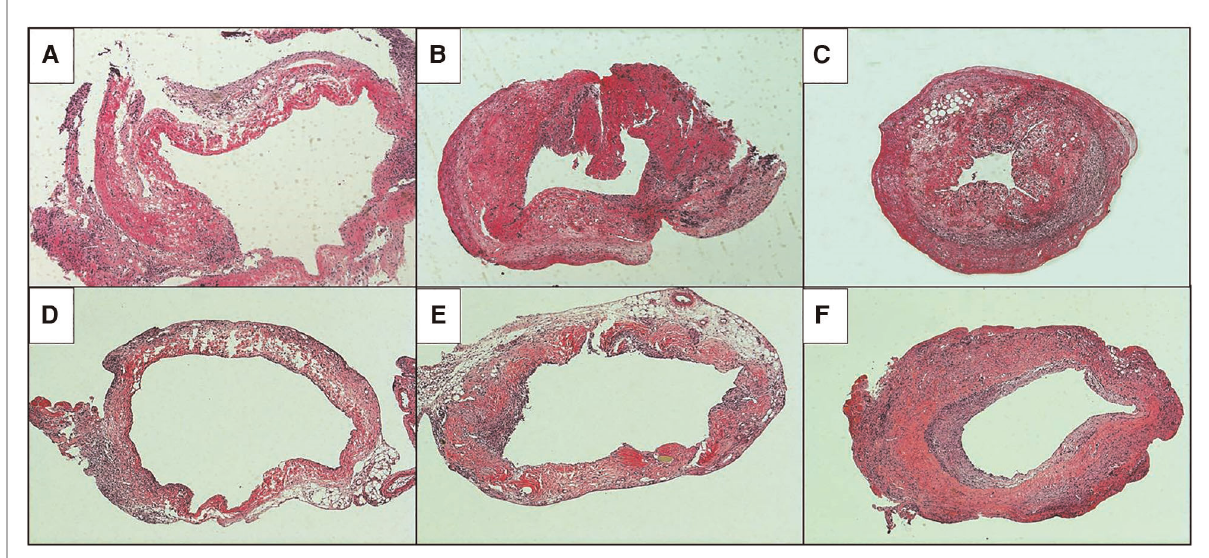
FIGURE 5 He staining of postoperative replacement vessels in two models of vein replacement (X50). ( A ) At 1 week after operation in the cuff group, a large amount of mononuclear cell in fi ltration was observed in the adventitial layer of the wall. ( B ) At 2 weeks after operation in the cuff group, mononuclear cell in fi ltration was observed in the whole wall. ( C ) At 4 weeks after operation in the cuff group, the intimal and muscular layer were signi fi cantly thickened, cellulose deposition was observed in the adventitial layer, and mononuclear cell in fi ltration was observed in the whole wall. ( D ) At 1 week after operation in the suture group, mononuclear cell in fi ltration was observed in the adventitial layer of the wall. ( E ) At 2 weeks after operation in the suture group, the thickening was observed in the every layer of the vessel wall. ( F ) At 4 weeks after operation in the suture group, the wall was thickened, especially in the intimal and muscular layer, and mononuclear cell in fi ltration was observed in the every layer of the vessel